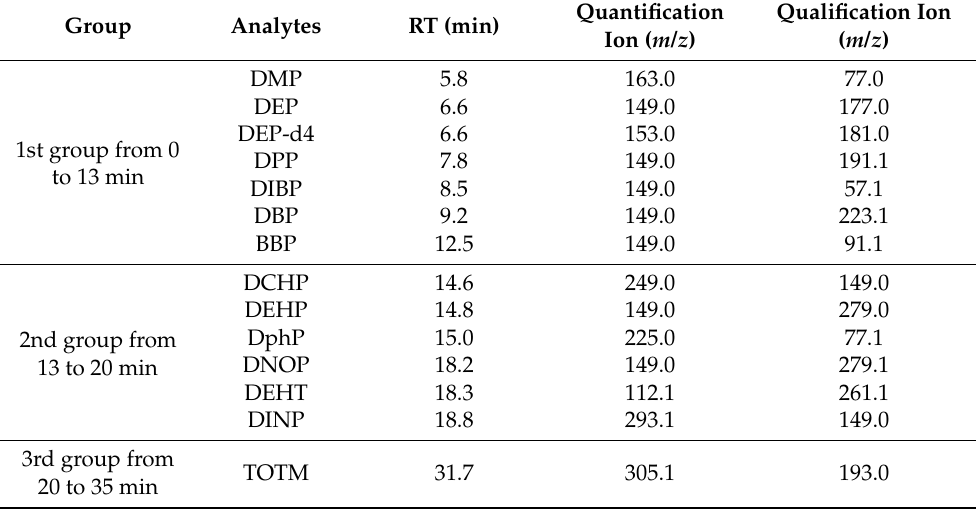
Table 2. Acquisition parameters for the GC–MS analysis of plasticizers and internal